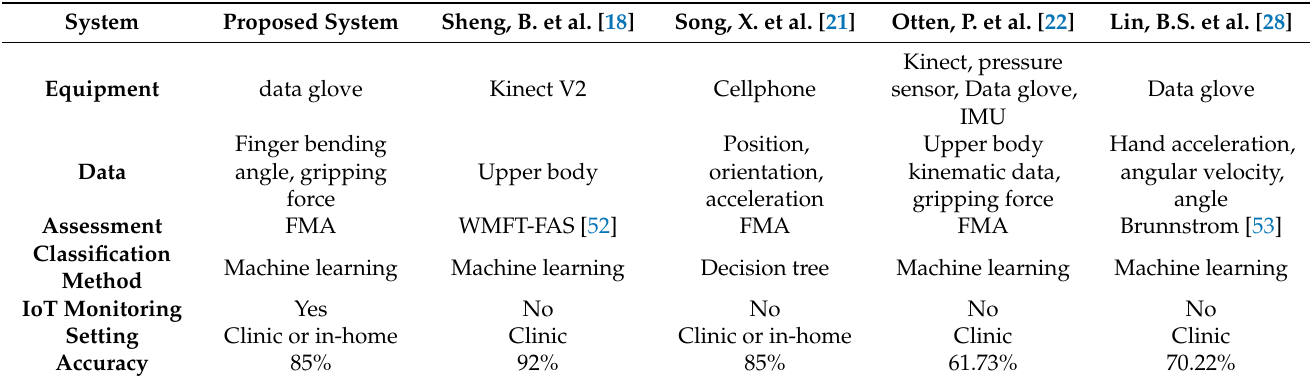
Table 8. Comparison to other